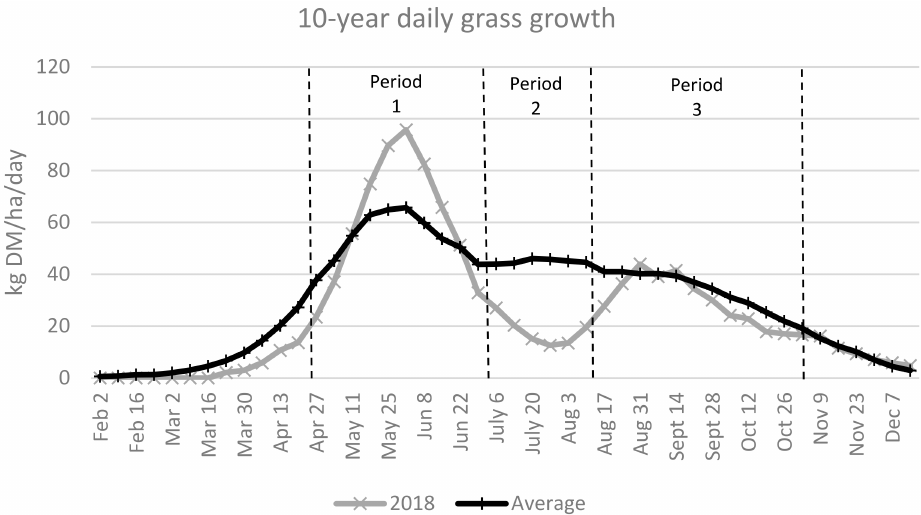
Figure 1. Daily grass growth for 2018 compared to the previous 10-year average and associated grazing periods implemented during the